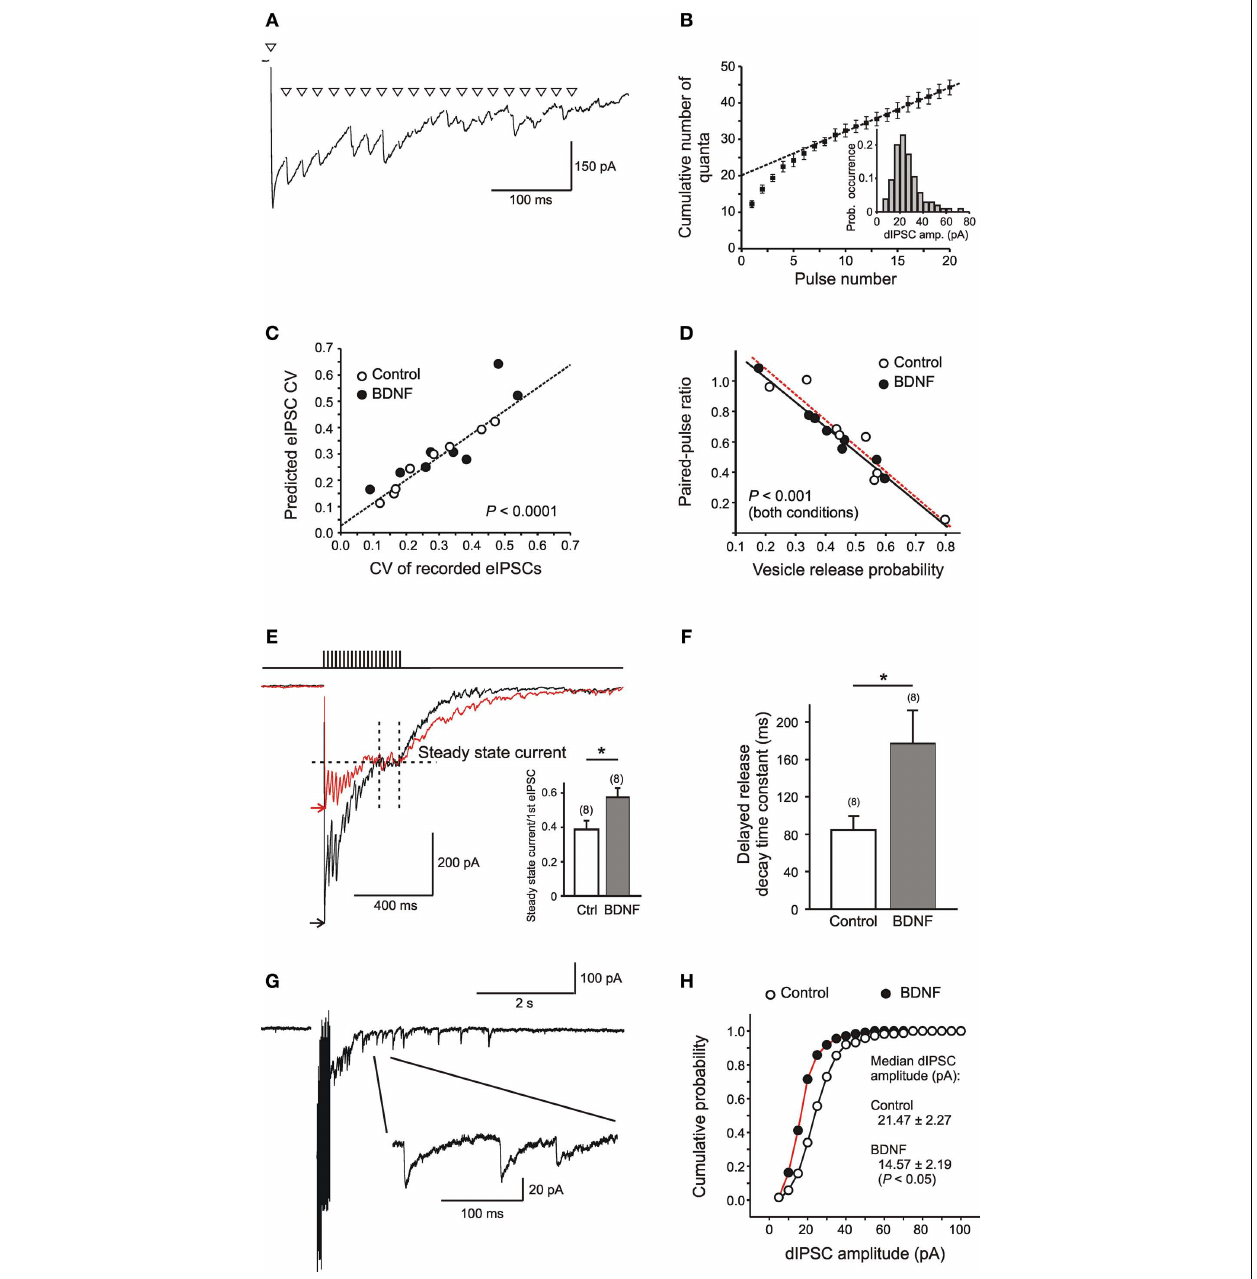
level of the eIPSC after the first pulse in the train. Note that BDNF does not affect the steady state current but significantly reduces the ratio between steady state current and first eIPSC (inset). (F) BDNF increases the time constant of decay of the “synaptic tail current,” i.e., the current produced by dIPSCs after the stimulus train, as estimated by single exponential fit. (G) Sample record of the postsynaptic response to HF stimulation of a single GABAergic axon. Note the presence of dIPSCs (inset: enlarged) after the end of stimulation. (H) Reduction of dIPSC amplitudes as evidence for a depressant postsynaptic effect of BDNF, in contrast to the absence of significant changes in the range of coefficient of variation (C) , paired pulse ratio, and p ves (D) . (Modified from Henneberger et al.,